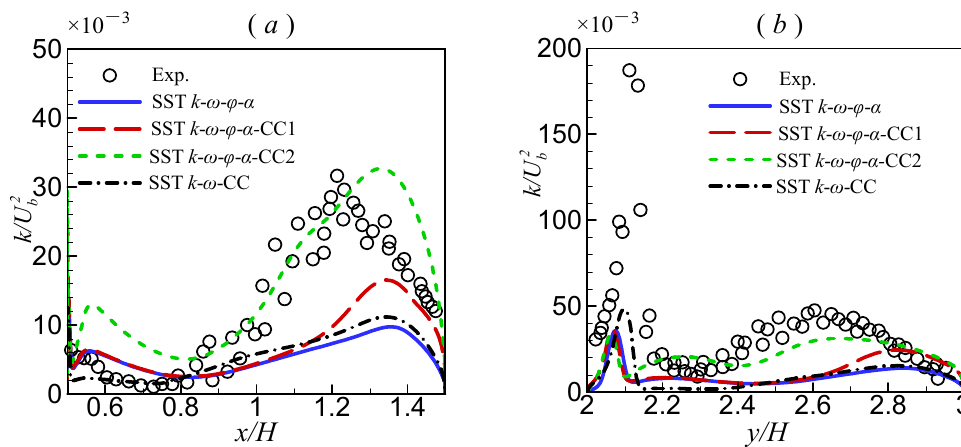
Figure 8. Comparison of turbulent kinetics along different transverse lines for the 2D U ‐ turn duct flow: ( a ) s / H = π /2, and ( b ) s / H = π . (cid:0) (cid:1) ρ U 2 The distributions of the friction coefficients ( C f = 2 τ w / ) along the inner and outer walls are depicted in Figure 9. The C f along the inner wall, predicted by the different turbulence models, varied little. The recovery of C f downstream in the re-circulation region is significantly delayed. Along the outer wall, the different turbulence models predicted C f differently. The original STT k - ω - ϕ - α model underpredicted while the STT k - ω -CC model overpredicted the peak of C f . The peaks predicted by the two proposed models were similar and agreed well with the experimental data.